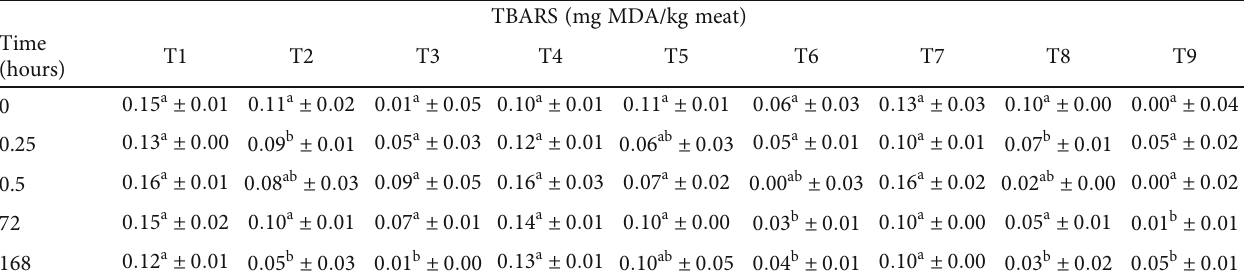
Table 5: Thiobarbituric acid reactive substances (TBARS) (mg MDA/kg meat) of chicken droëwors with added Moringa oleifera leaf meal